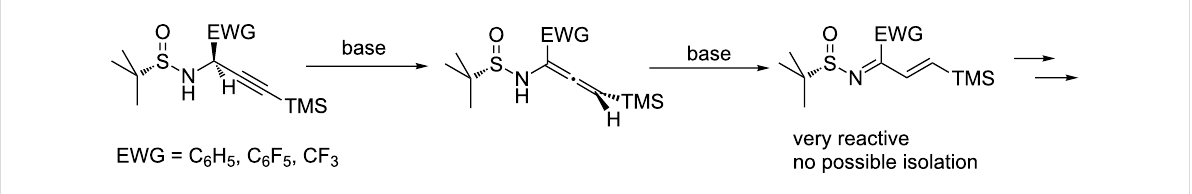
Figure 8: Base-induced rearrangement of propargylamines bearing electron-withdrawing substituents.